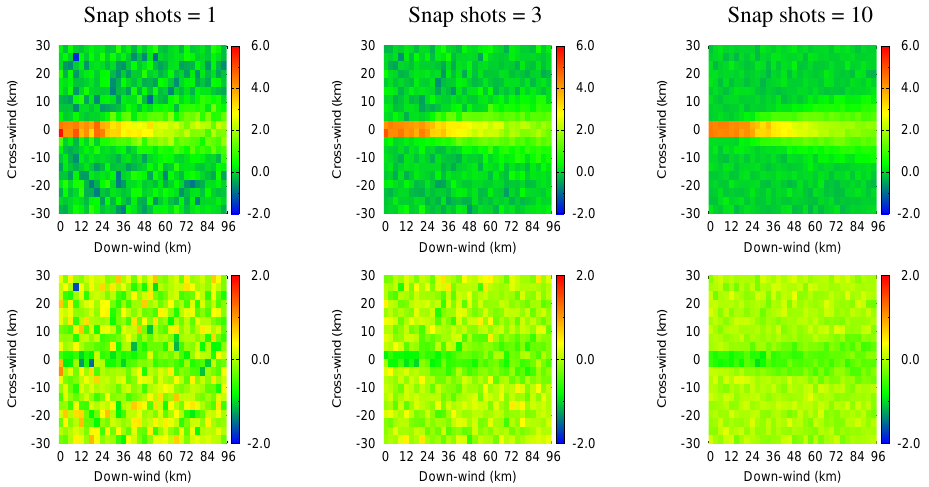
enhancement. At 2 list the estimates for the 2